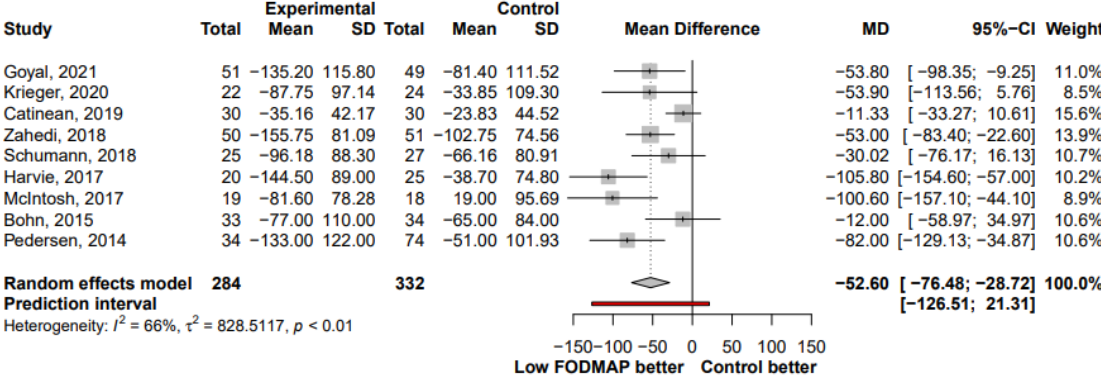
Figure 4. Forest plot showing odds ratios for clinical improvement in IBS symptoms as a proportion of responders based on reduction in IBS ‐ SSS > 50 or a positive response to an IBS adequate symptom relief question. OR, odds ratio; CI, confi ‐ dence interval .